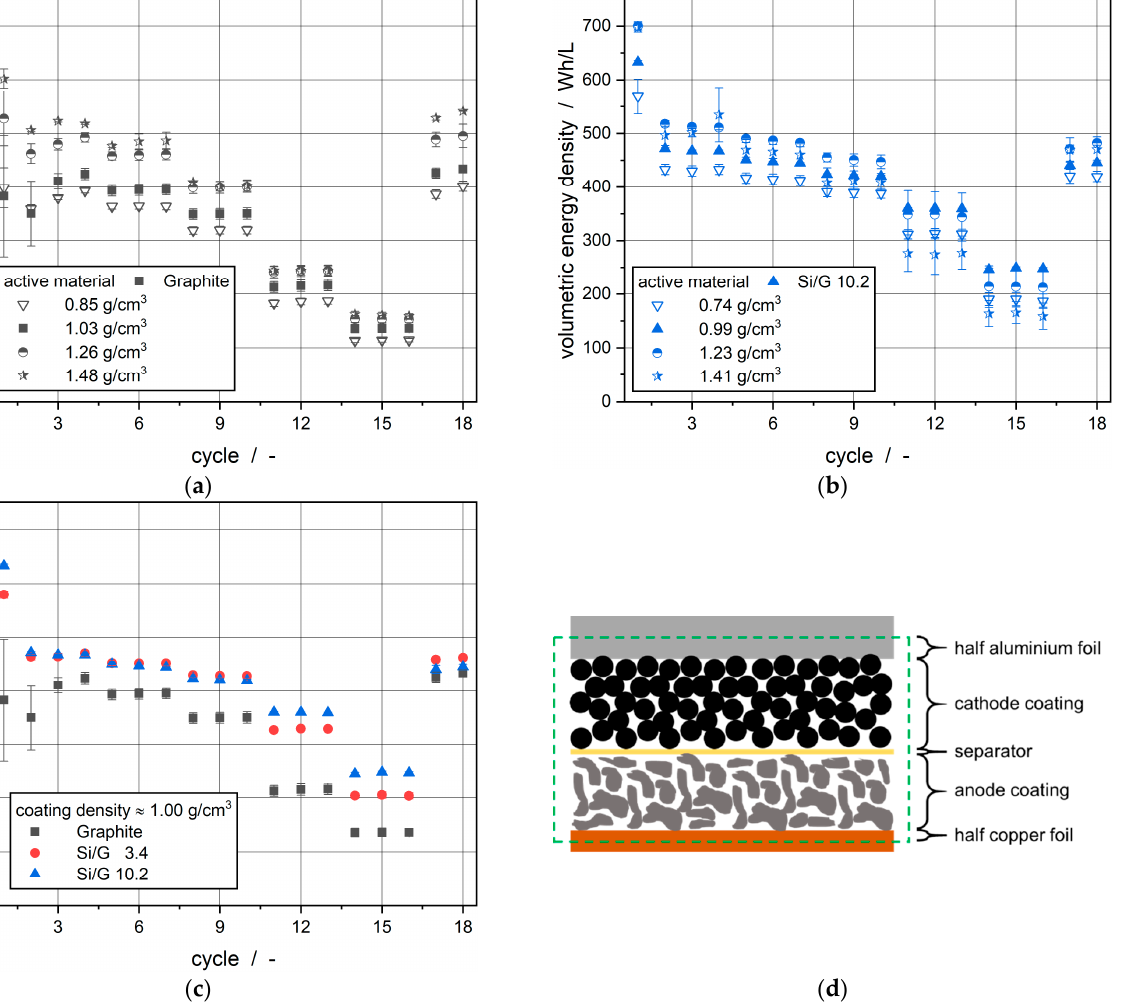
Figure 7. Volumetric energy densities at C ‐ rate ‐ tests of full cells in pouch cell setup of the ( a ) graphite electrode at different coating densities; ( b ) Si/G 10.2 electrode at different coating densities; ( c ) electrodes with a coating density of ≈ 1.00 g/cm 3 ; ( d ) included parts for calculation of volumetric energy density of a battery compartment. Table 4. Area and height of the used components for full cells in a pouch cell setup.